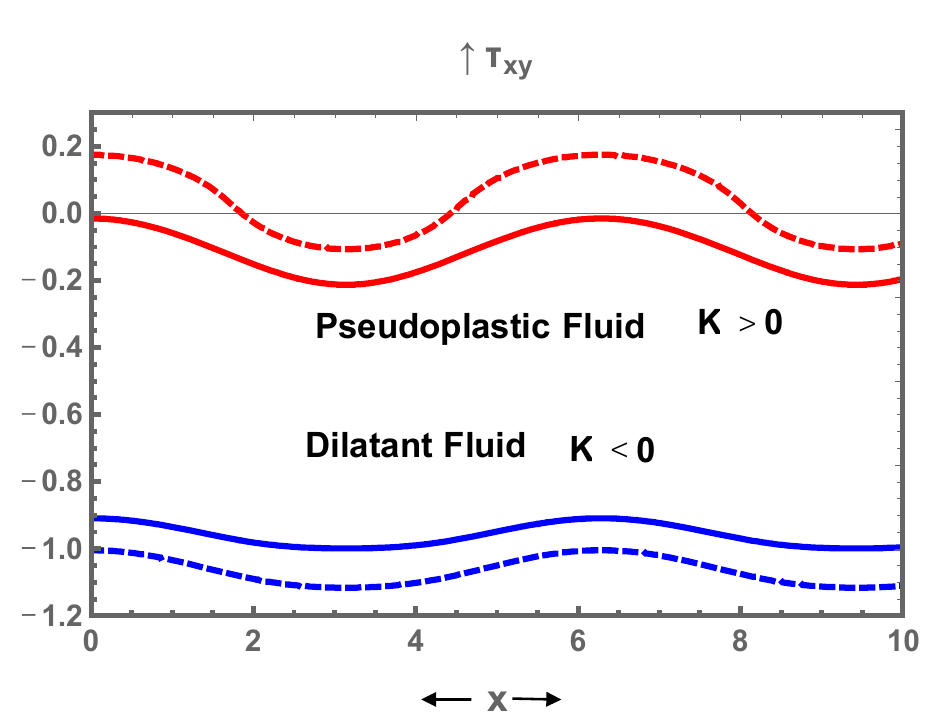
Figure 8. Display of shear stress profile via x for pseudoplastic and dilatant fluids.